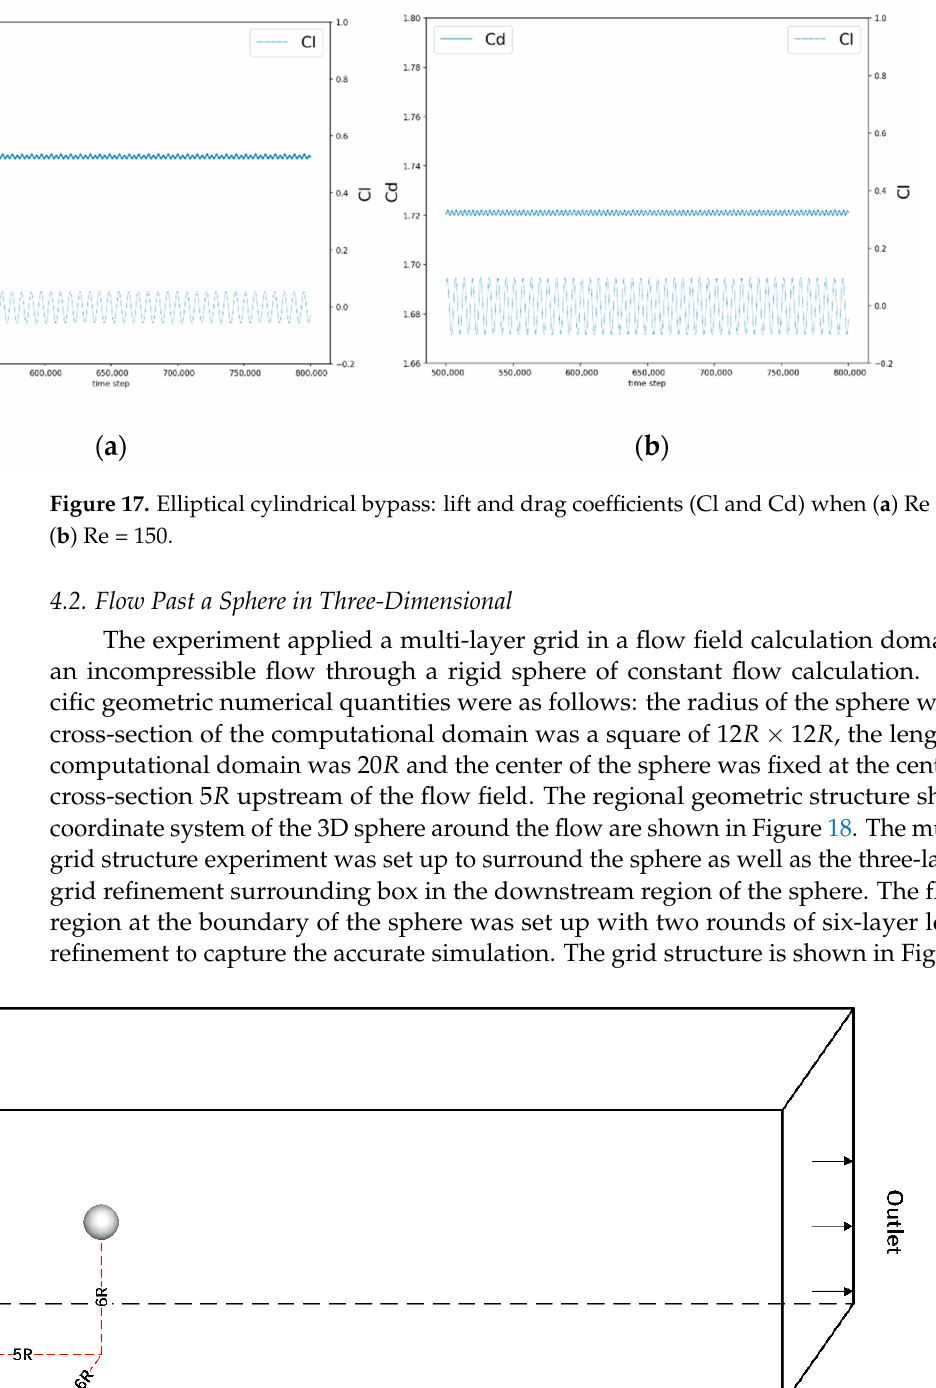
Table 2. Average drag coefficients for elliptical cylindrical bypass flow at different Reynolds num- bers, and comparison with previous studies.